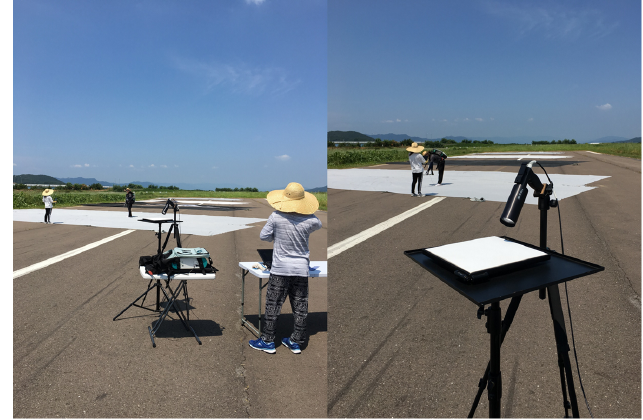
Figure 5. Picture showing radiance measurements of a white reference panel and calibration tarps using a dual ASD Fieldspec ® 3 radiometer system at Goheung site in South Korea.